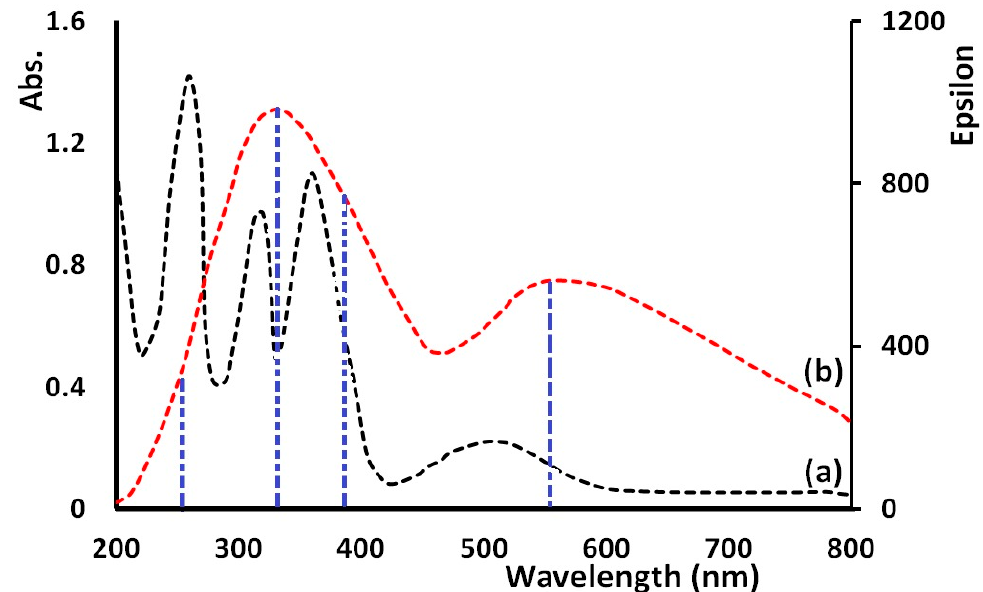
Figure 3. FTIR of cis -Cu(II) complex: experimental ( a ) and DFT ( b ).